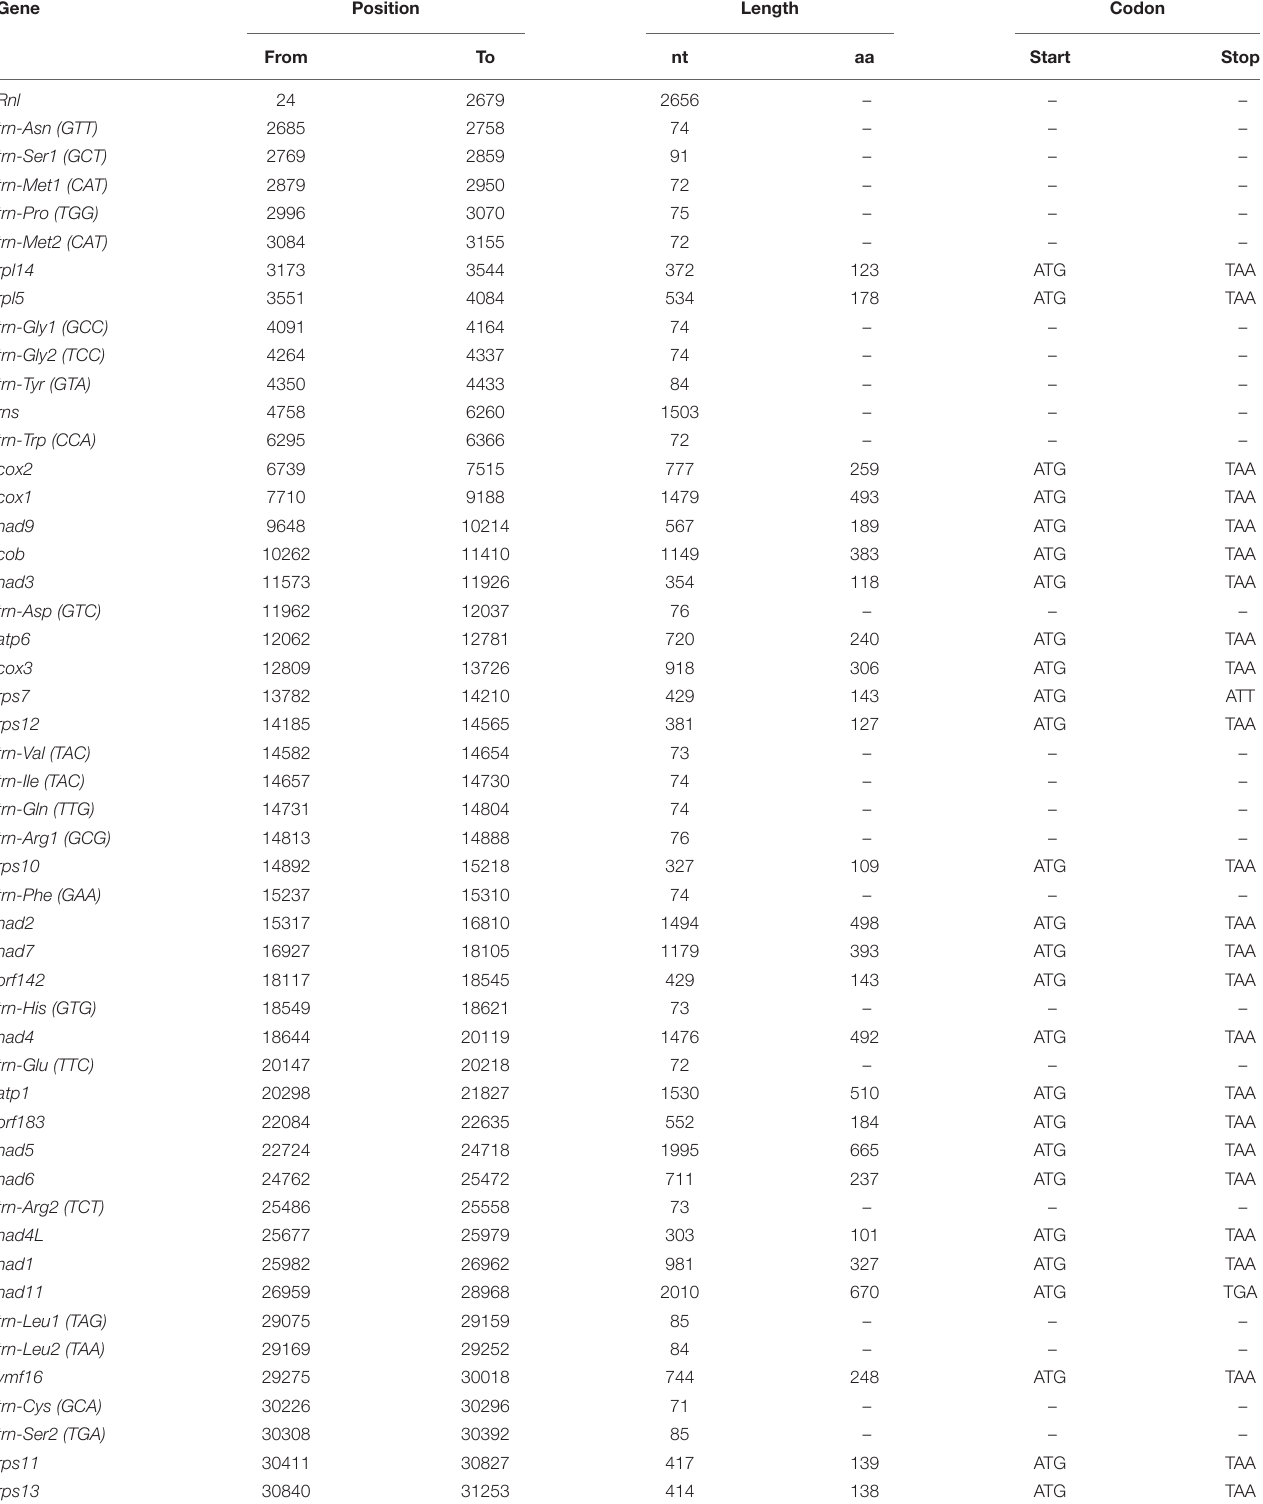
TABLE 2 | Gene organization of the P. nicotianae mitochondrial